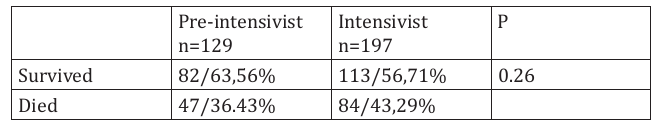
Table 2 Mortality rates